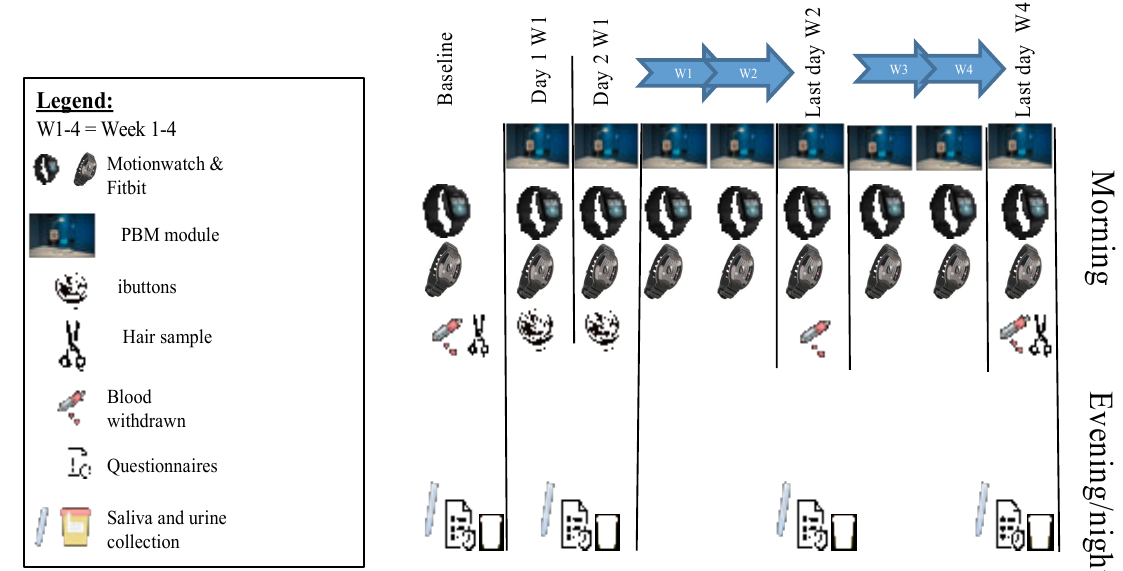
Figure 2. Schematic overview of the study design and performed measurements.